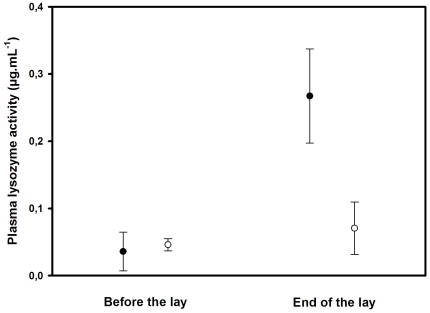
Effect of the preen-gland treatment on plasma lysozyme concentration (±SE) in breeding female mallards.White points represent females with free access to the preen gland while black points represent females for which preen gland access was blocked.